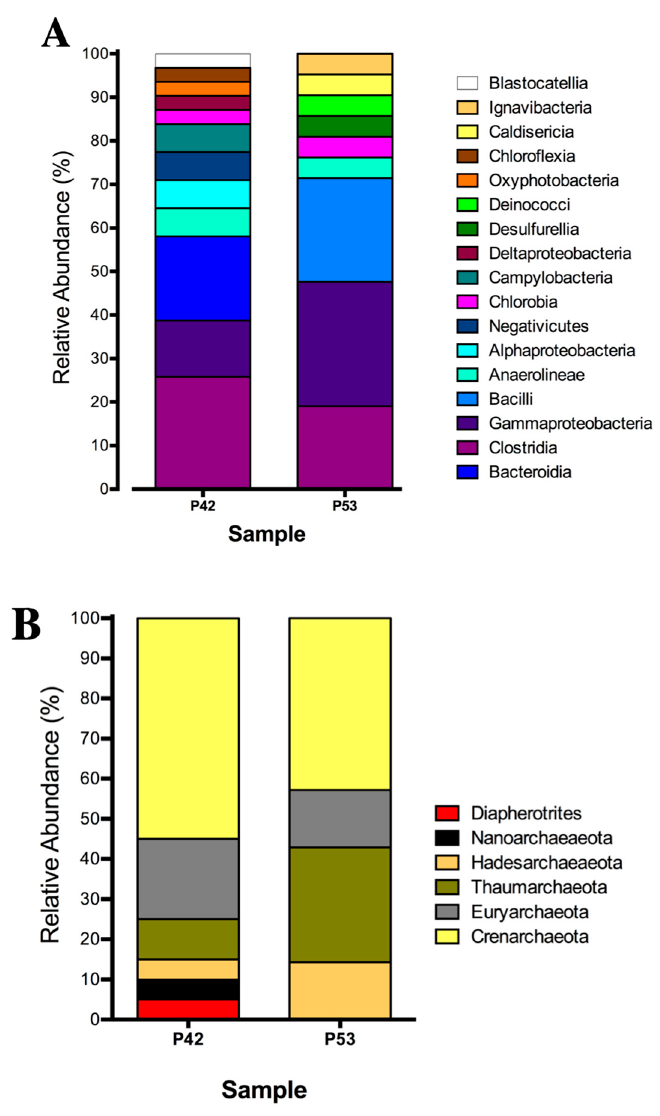
Figure 2. Relative abundance of the 16S rRNA gene clonal analysis that was classified at the phylum level of the microbial community structure from the hot springs at the Lirima hydrothermal system.